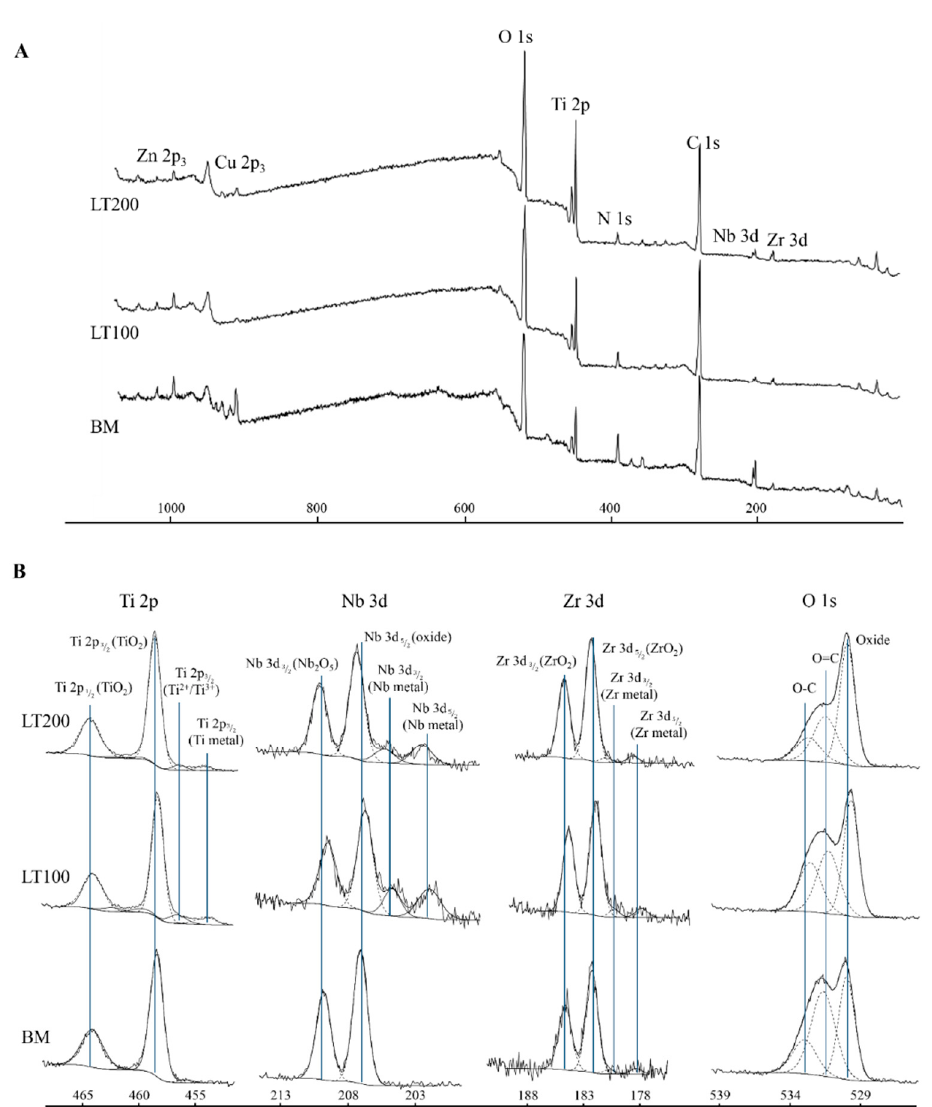
Figure 4. XPS spectra of untreated and laser treated samples. ( A ) XPS spectra: Zn 2p 3 , Cu2p 3 , O 1s, Ti 2p, N 1s, C 1s, Nb 3d and Zr 3d. ( B ) XPS narrow scan spectra: Ti 2p, Nb 3d, Zr 3d and O 1s for untreated and laser treated surfaces. X-axes show binding energy (eV).